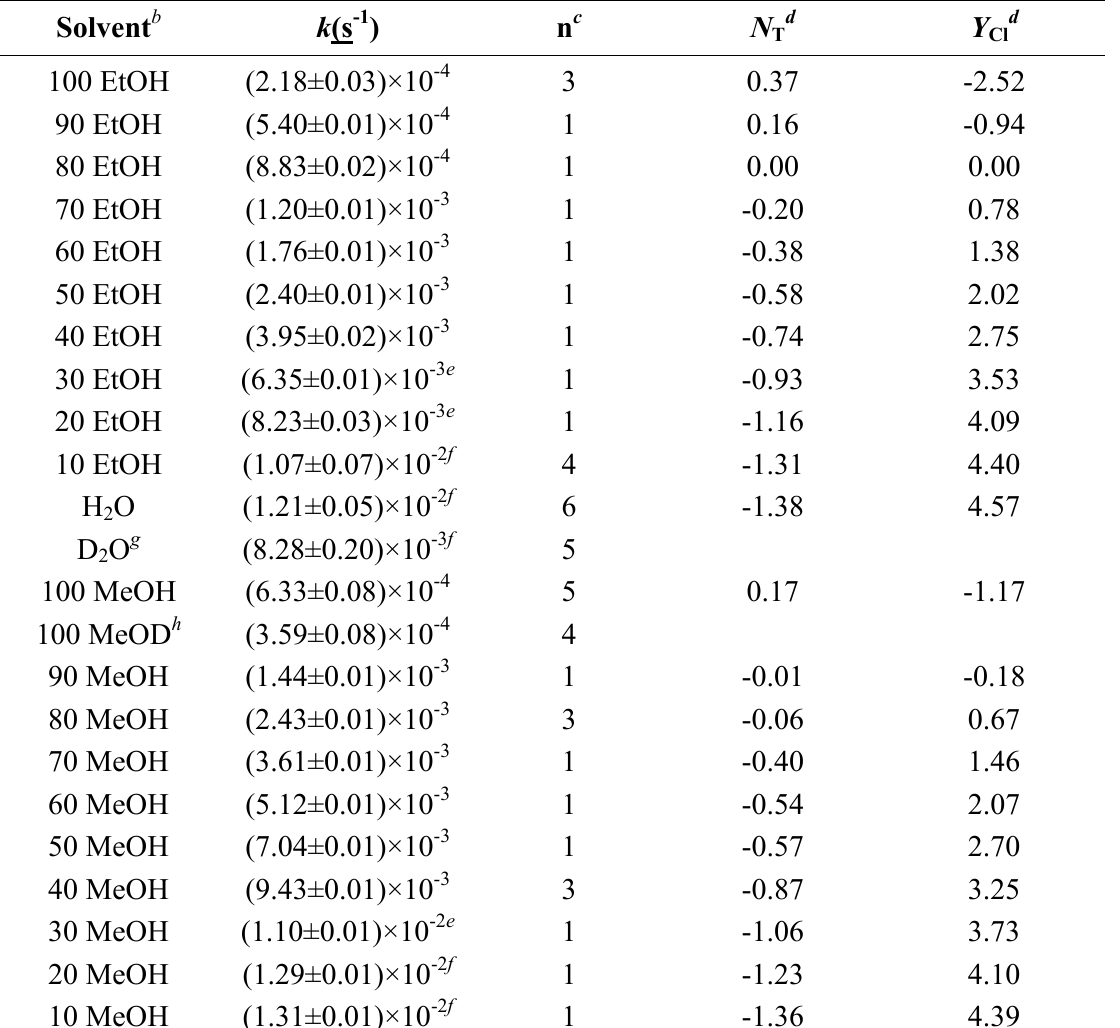
(Table 2) and 97% TFE (Table 4), two solvents of similar ionizing power but very different solvent nucleophilicities, ( k / k ) is 846, indicating that solvent nucleophilicity is an important rate- 40EtOH 97TFE controlling factor [3, 22, 42]. The correlation of the specific rates of solvolysis of 3 , in all 43 solvents and using the extended Grunwald-Winstein equation, is presented in Figure 4. Table 2. Specific rates of solvolysis ( k ) of trans - β -styrenesulfonyl chloride ( 3 ) a in pure ethanol, methanol, and water, and in alcohol-water binary mixtures at 45.0